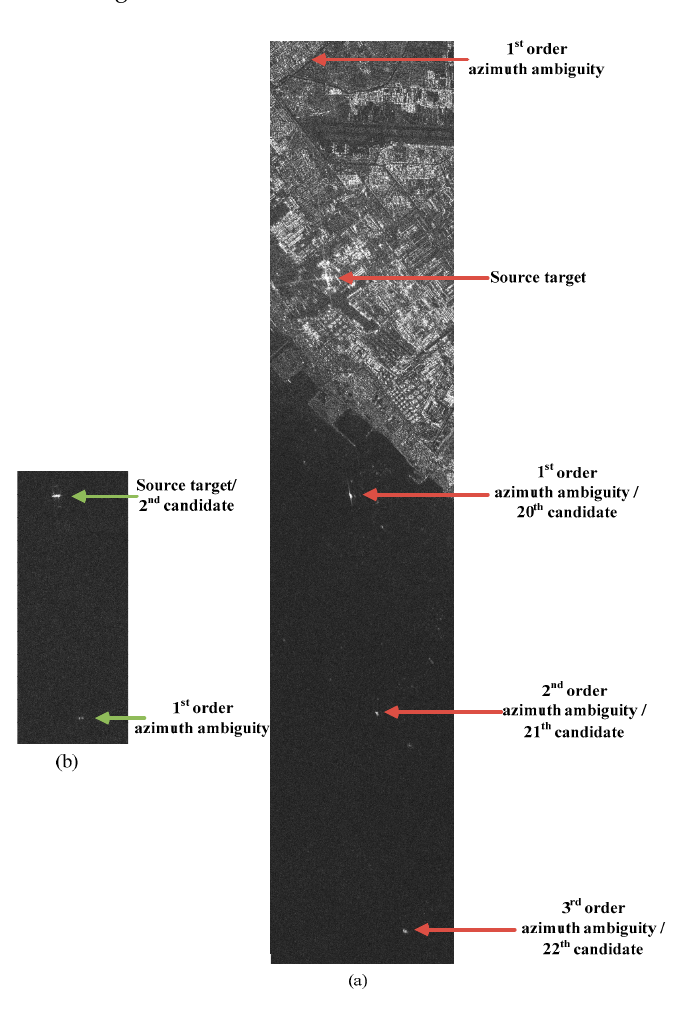
Figure 17. Azimuth ambiguities caused by a ship target ( a ) and land-based sources ( b ) in test image ID 1.